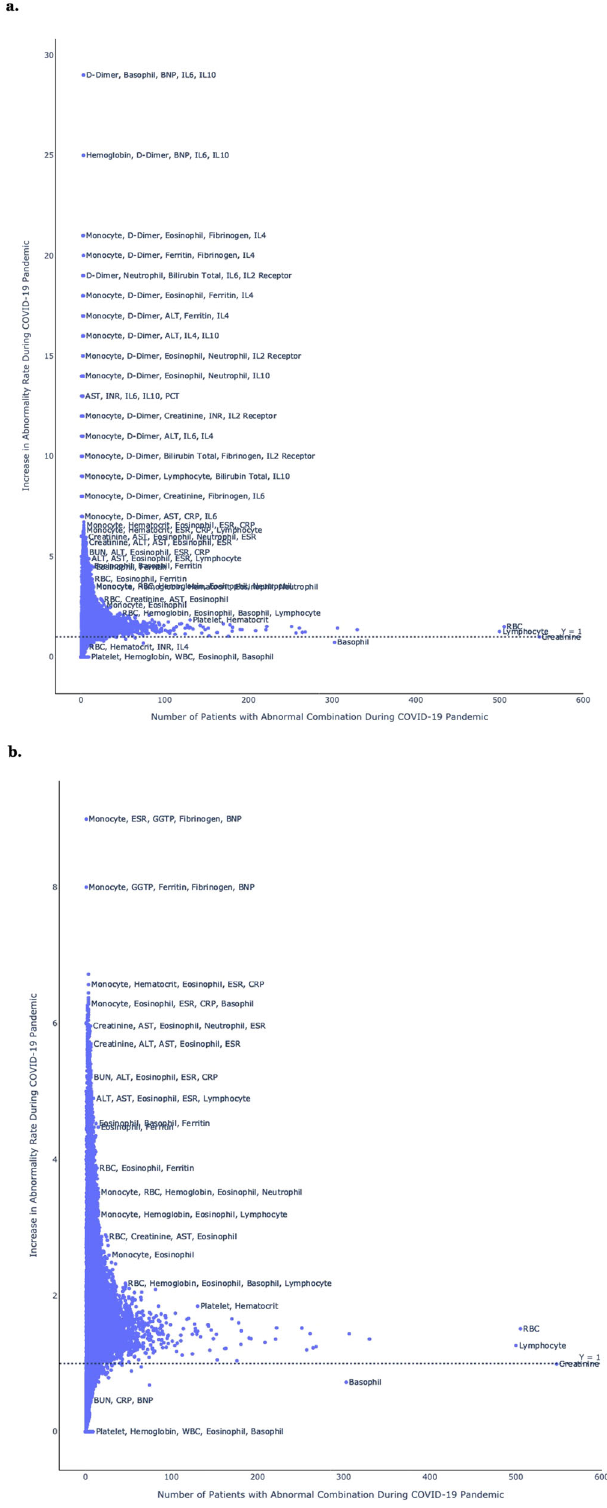
Fig. 4 Population approach, overview. Systematic comparison of all laboratory test combinations observed during the COVID pandemic, according to the number of abnormal test results (X- axis), and the percentage increase in test abnormality rates relative to historical baseline (Y-axis). Results are shown a with Interleukin (IL) tests and b without Interleukin (IL)